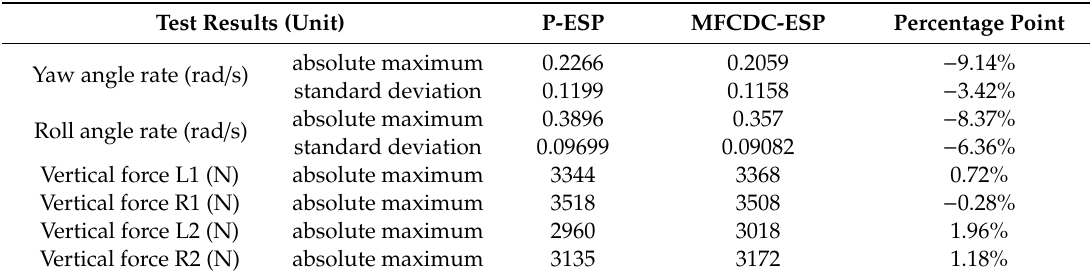
Table 10. Main comparison results of DLC test (P-ESP,